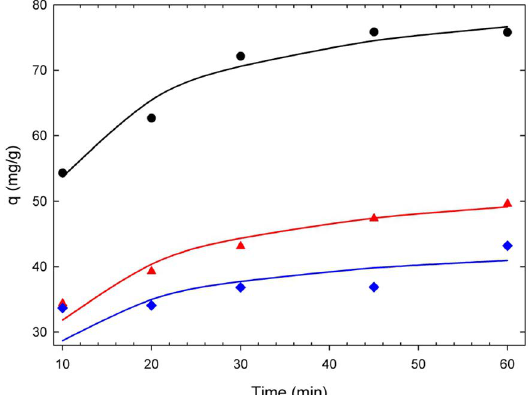
Figure 5. The Adsorption of Pb(II) at different initial concentration onto HA.